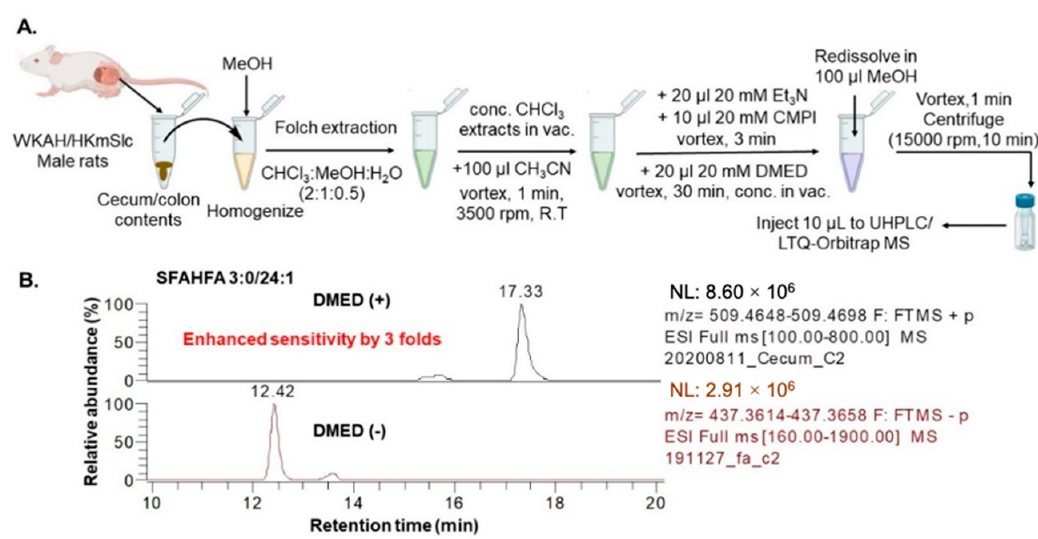
Figure 1. ( A ) Extraction and 2-dimethylaminoethylamine (DMED)-labeling workflow for detection of short-chain fatty acid esterified hydroxy fatty acids (SFAHFAs) ( B ) Extracted ion chromatograms (EICs) of a representative SFAHFA 3:0 / 24:1 molecular species with (in positive mode) and without DMED labeling (in negative mode). Table 1. List of all the DMED-labeled-SFAHFAs identified with their exact masses.